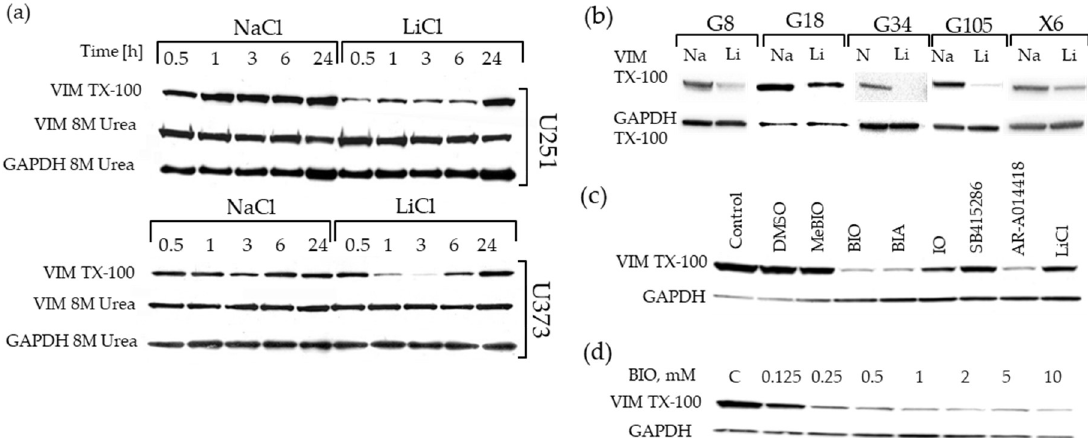
Figure 5. Downregulation of vimentin in detergent soluble extracts from GBM cells treated with LiCl, and a panel of small molecular glycogen synthase kinase-3 (GSK-3) inhibitors: ( a ) Validation in GBM cell lines. U251 and U373 glioma cells were treated with 20 mM LiCl or NaCl, for the time (hours) as indicated. Vimentin levels were determined in triton-x-100 extracts and in “total” extracts in 8 M urea. ( b ) Effects of 20 mM LiCl across a panel of GBM cell lines 3 h post-treatment. ( c ) Effects of a panel of GSK-3 inhibitors on vimentin levels in U251 cells 3 h post-treatment. ( d ) Dose-dependent effects of 6-bromo-indirubin-3-oxime (BIO) on triton-x-100 soluble vimentin levels 3 h post-treatment.